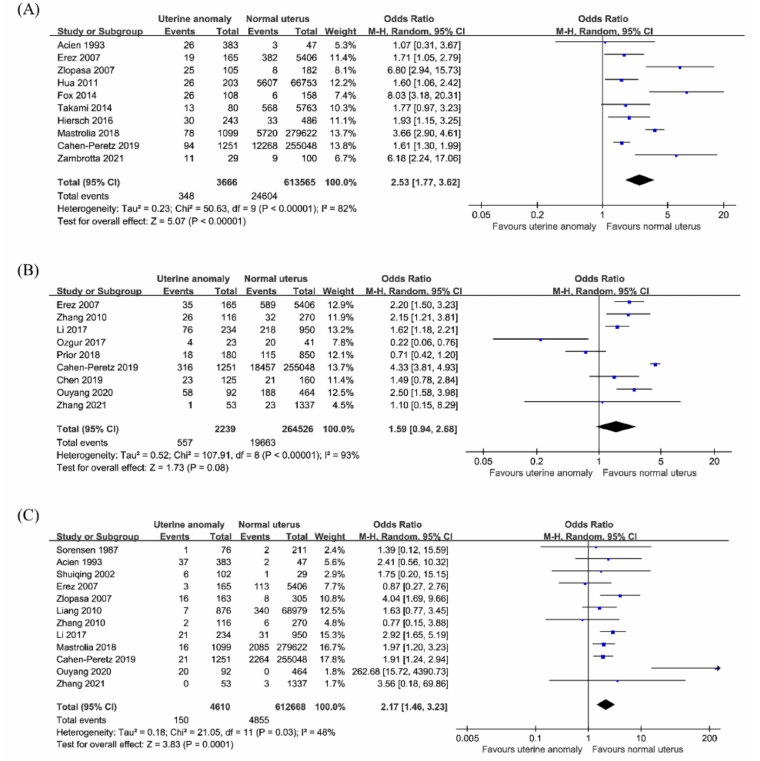
Figure 4. Neonatal outcomes in women with congenital uterine anomalies. ( A ) Intrauterine growth restriction or small for gestational age, ( B ) low birth weight, ( C ) perinatal